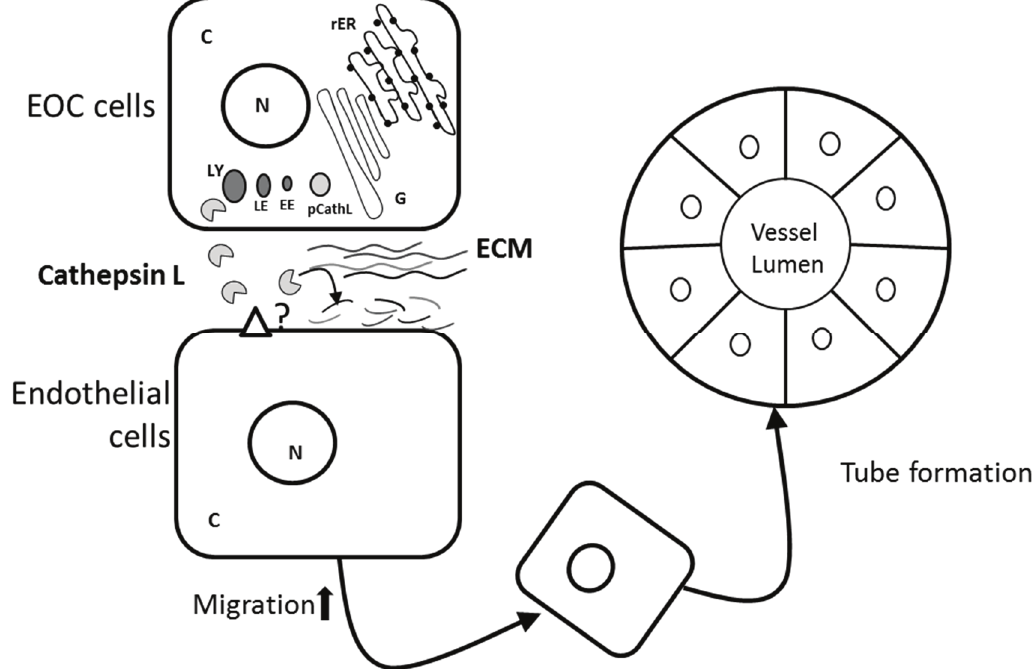
Figure 2. Potential proangiogenic role of cathepsin L in EOC. Procathepsin L (pCathL) is synthesised and processed in the rough endoplasmic reticulum (rER) and Golgi bodies (G), and subsequently translocated to early endosome (EE), late endosome (LE) and finally lysosome (LE). Mature CathL is secreted by epithelial ovarian cancer (EOC) cells and induces migration in endothelial cells via an unknown receptor. Tumor-secreted CathL may also degrade extra cellular matrix (ECM) components, facilitating new vessel